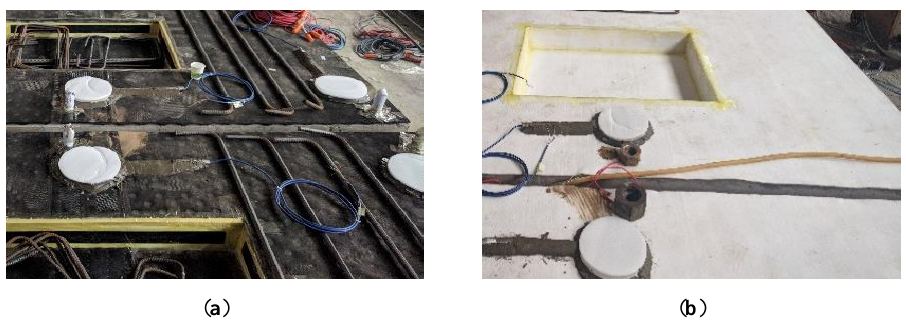
Figure 3. Different types of isolation layers in ballastless tracks. ( a ) Rubber isolation layer; ( b ) geotextile isolation layer.